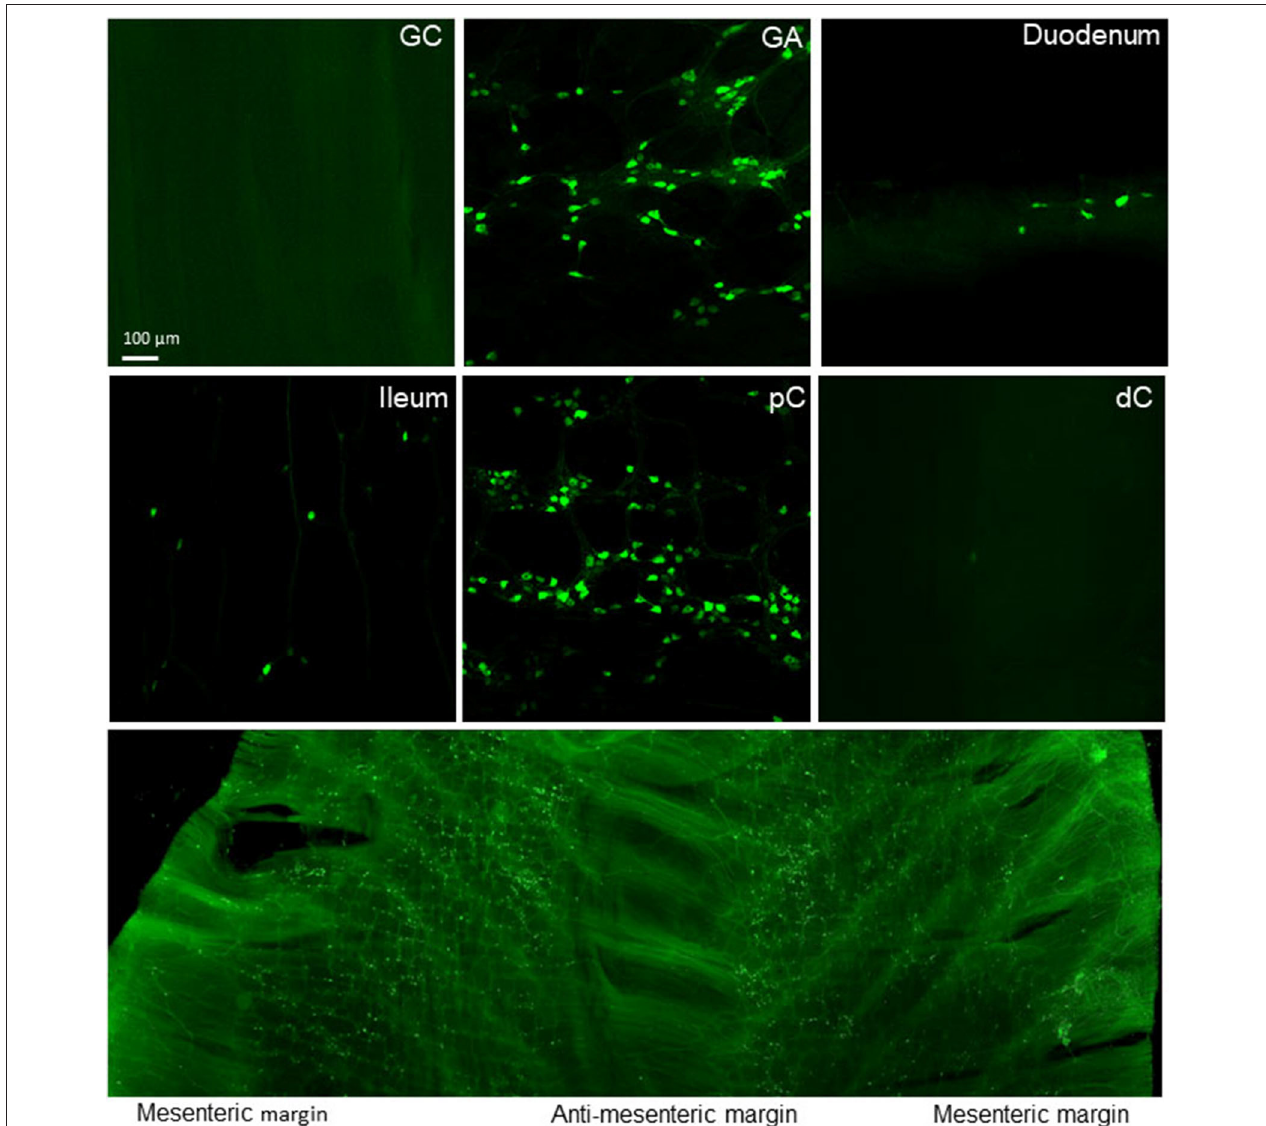
FIGURE 15 | GI mapping in nNOS-Cre mice. AAV-PHP.S-CAG-DIO-EYFP was retro-orbitally injected at injected at 3.3 x 10 11 GC/mouse 3 weeks before. The lower panel show unevenly distributed iv AAV-transduced nNOS neurons in the proximal